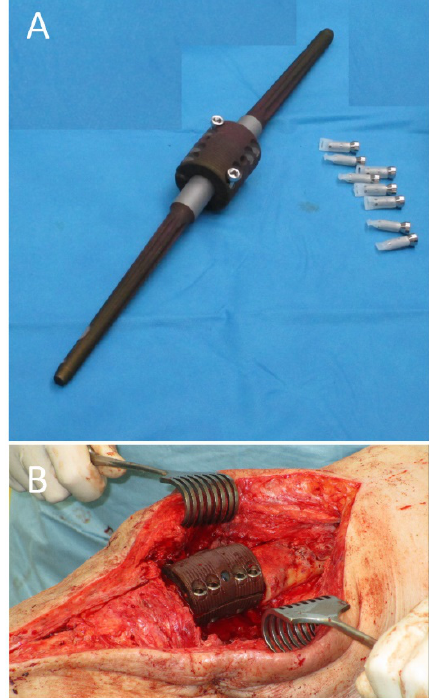
Figure 3. ( A ) Metallic silver-coated intramedullary knee arthrodesis system with locking bolts (uncoated) The Metallicsilver coated parts (intramedullary femoral, intramedullary tibial and spacer) appear black. ( B ) Intraoperative image after implantation of the silver-coated knee arthrodesis system with complete locking of the two spacer parts with 8 locking bolts (4 lateral, 4 medial (not visible)) between the intramedullary femoral component (right) and the intramedullary tibial component